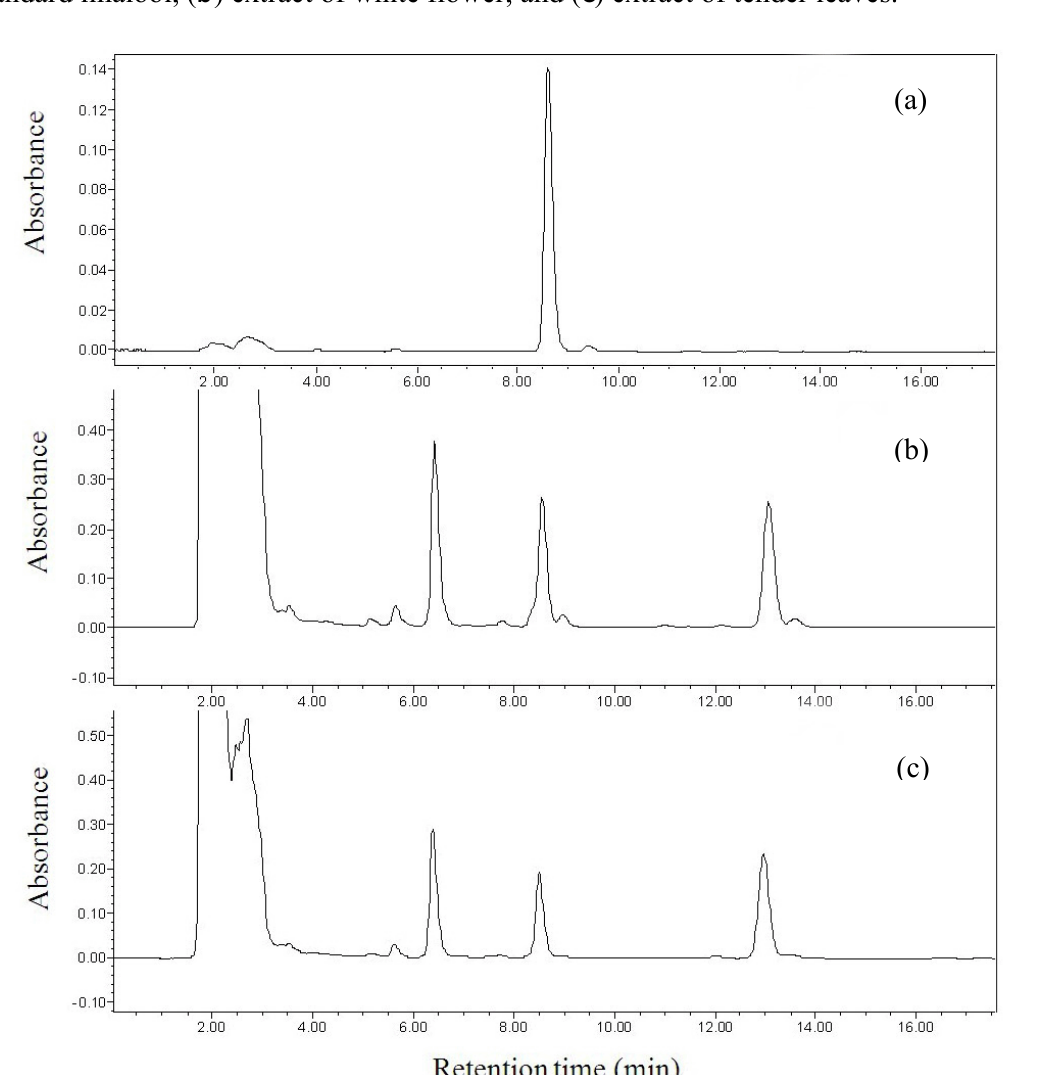
Figure 1. Chromatograms of standard linalool and the extracts of Michelia alba : ( a ) standard linalool, ( b ) extract of white flower, and ( c ) extract of tender